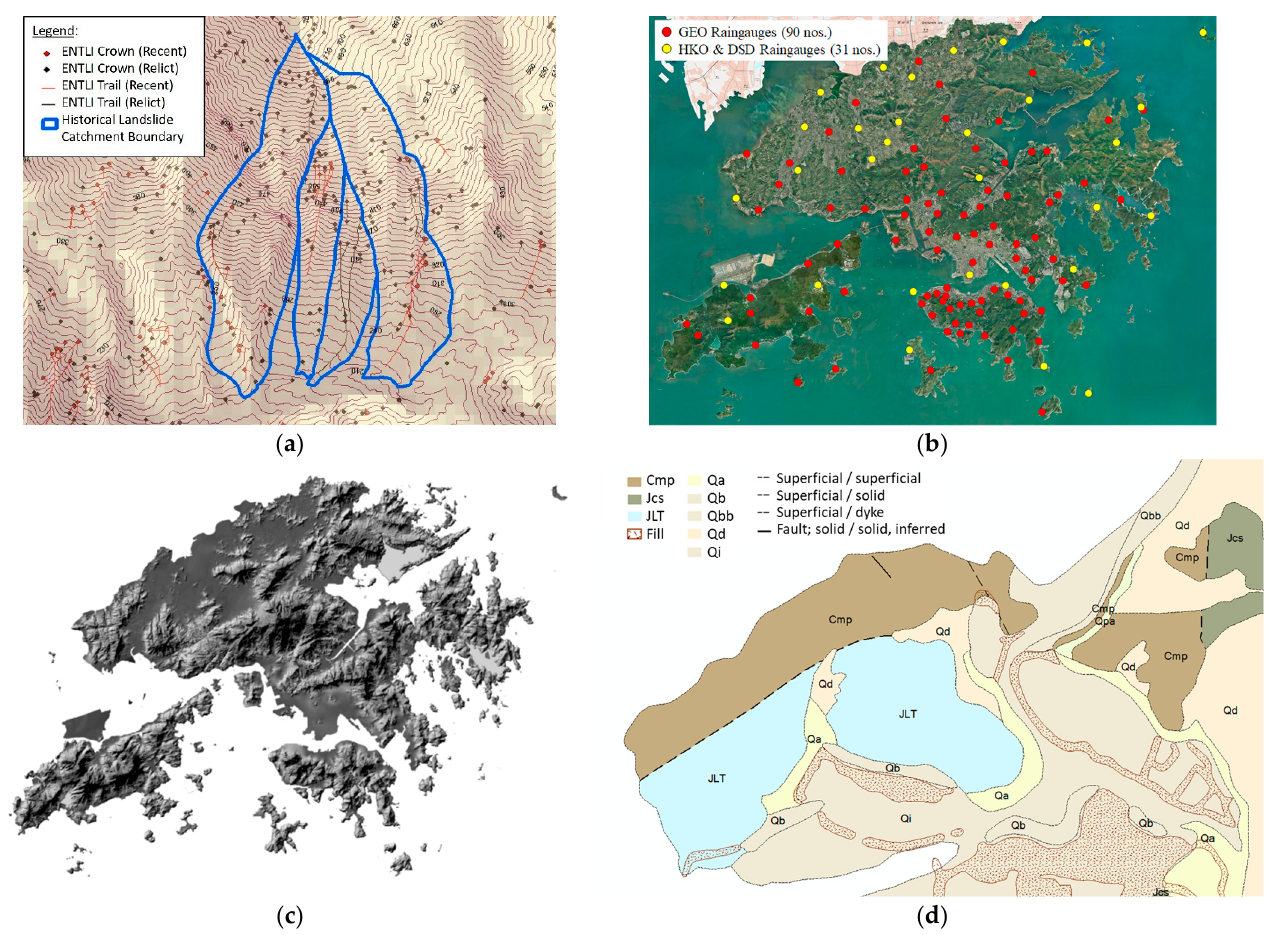
Figure 2. Hong Kong’s Landslide-related data inventories adopted in the current study: ( a ) Spatial distribution of natural terrain landslides in ENTLI up to 2019; ( b ) Location plan of rain gauges for the operation of the Landslip Warning System; ( c ) Digital elevation model (DEM) based on LiDAR survey results in 2010; ( d ) Extract of the 1:20,000-scale geological map.